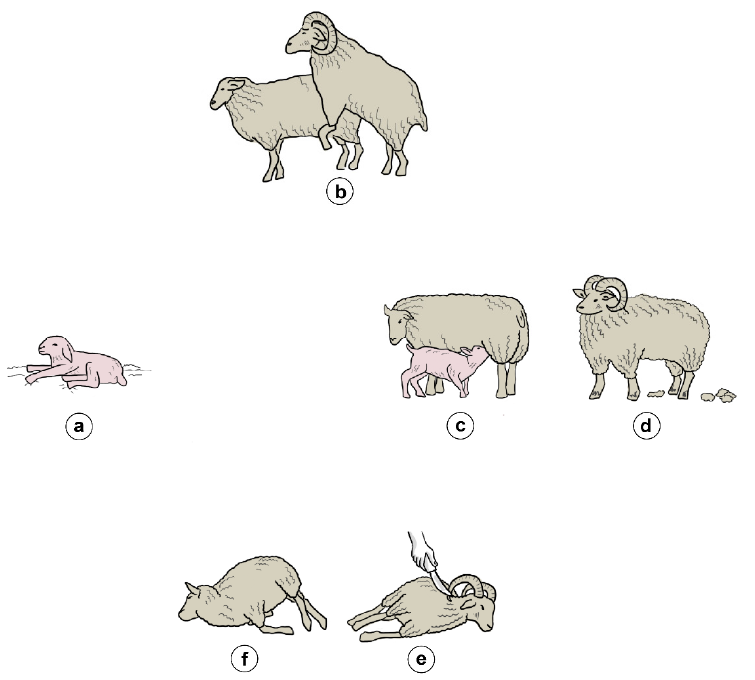
Figure 3. Key stages of the sheep lifecycle: ( a ) birth, ( b ) reproduction, ( c ) lactation, ( d ) wool growth and ( e , f ) death. and ( e , f )